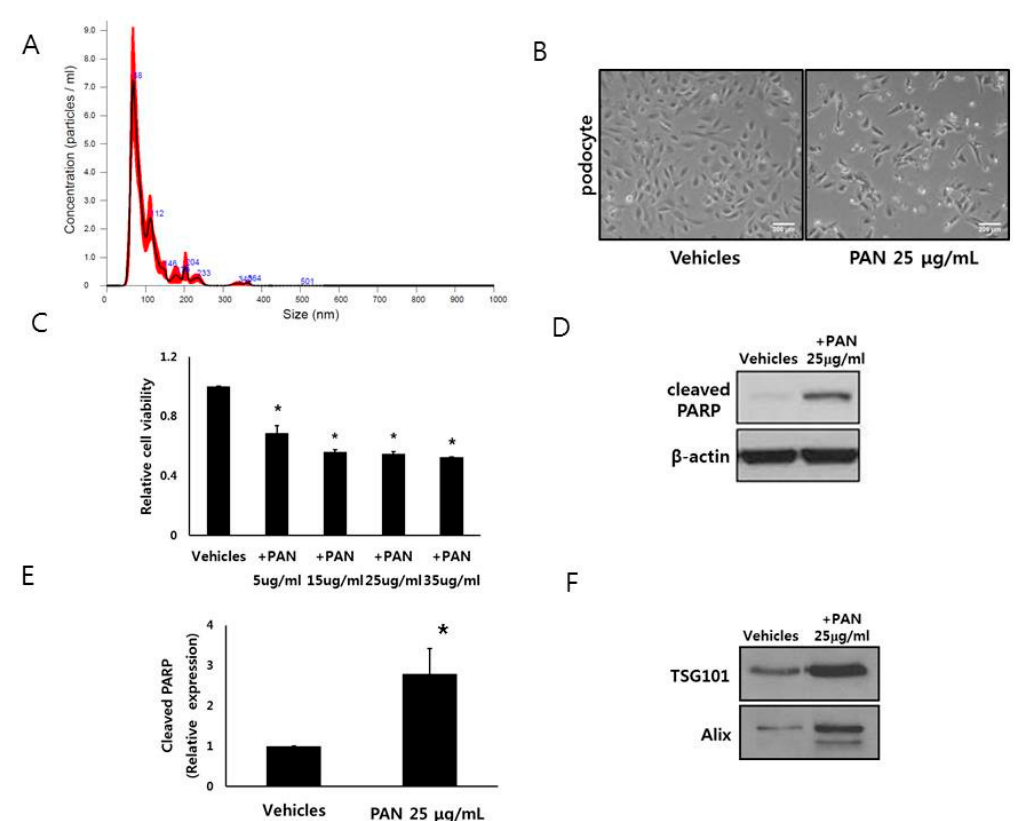
Figure 1. Podocytes release extracellular vesicles (EVs). ( A ) Size distribution of isolated podocyte EVs as determined by nanoparticle tracking analysis. ( B , C ) Number of podocytes after PAN exposure was decreased. ( D , E ) PAN treatment (25 µ g / mL) induced apoptosis of podocytes. ( F ) Number of EVs from PAN-exposed podocytes was more than that of control podocytes. HP; human podocyte, PAN; puromycin aminonuceloside. * p < 0.05 vs. HP